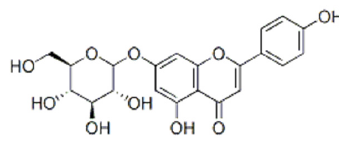
Table 2. The contents of eight components in ST from 13 different origins in China (mg/g) [21].